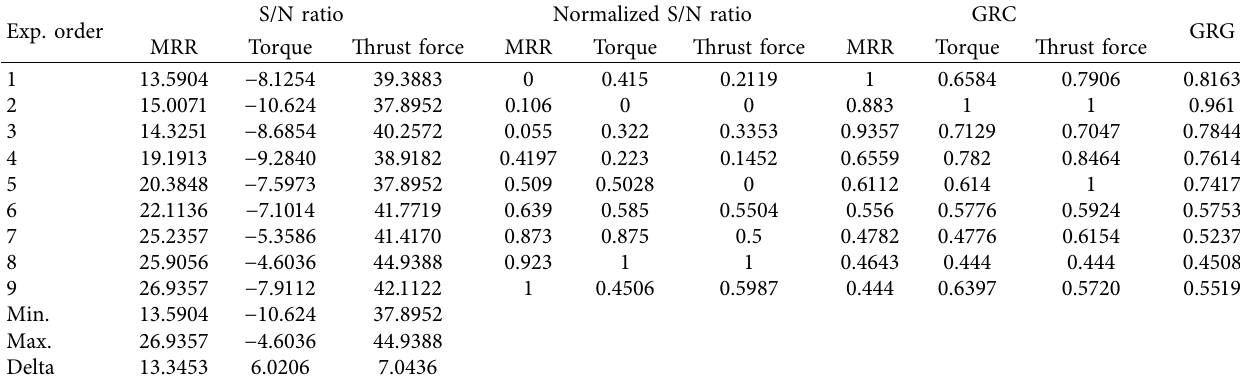
Table 17: Calculation of Grey Relational Grade (GRG) values.